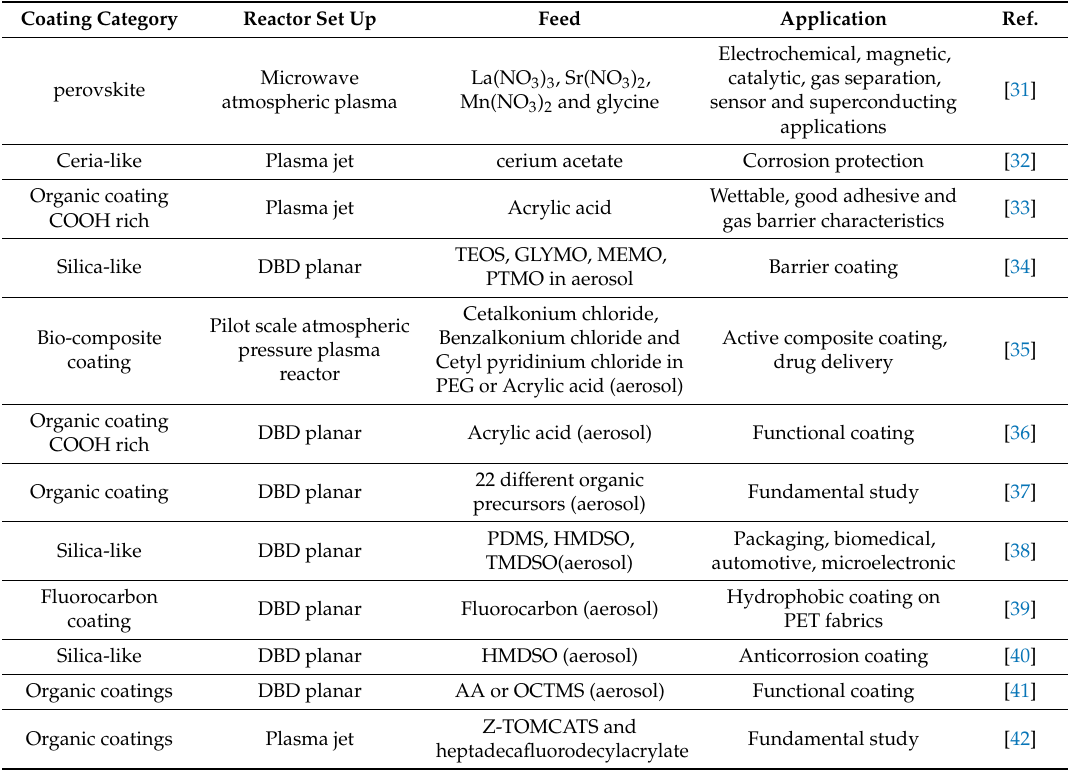
Table 1. Selected examples of aerosol-assisted plasma deposition (AAPD) deposited